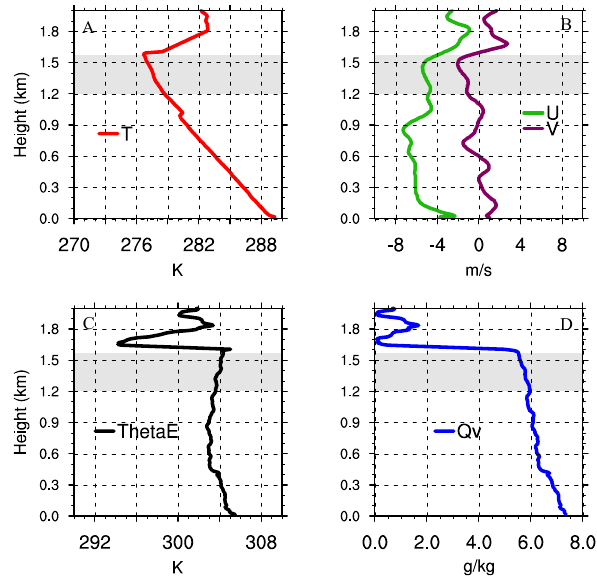
Fig. 1. Sounding of decoupled subtropical stratocumulus at 23:27Z 5 May 2009 over Graciosa Island, Azores, Portugal (39.13 ◦ N, 28.94 ◦ W). (A) Temperature, in units of K. (B) Horizontal winds, in units of ms − 1 . (C) Equivalent potential temperature, in units of K. (D) Specific humidity, in units of gkg − 1 . Gray shading marks the cloud